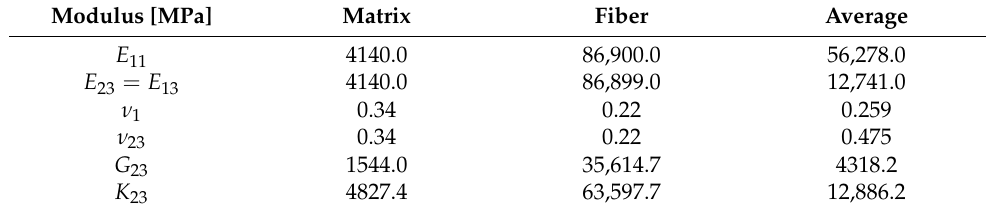
Table 2. Computed values of elastic moduli (Case 1).